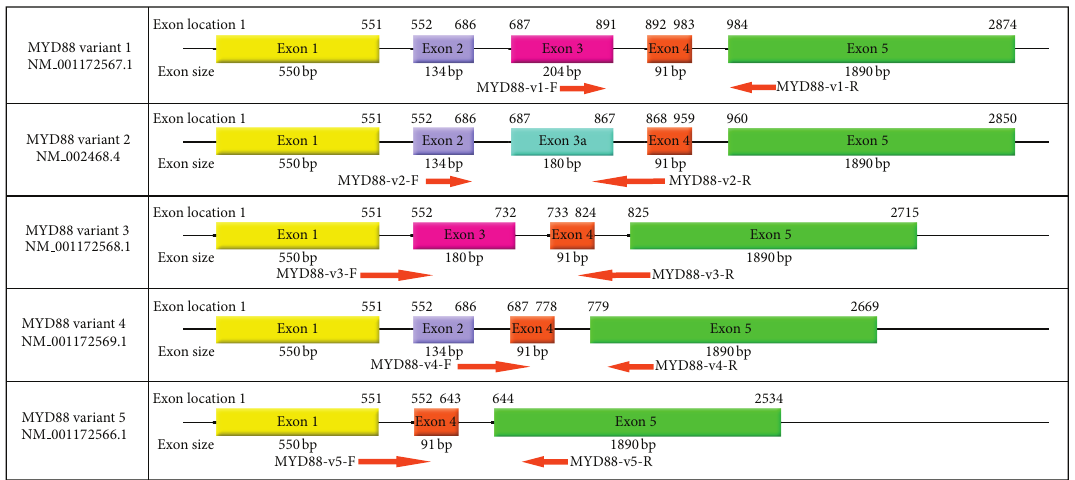
Figure 1: Alternative splicing variants of the MYD88 gene and designed primers locations.